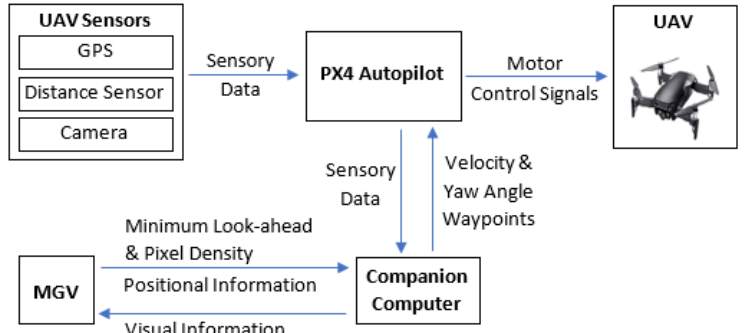
Figure 3. The simulation framework of the proposed ED-APF for MGV reconnaissance and look- ahead